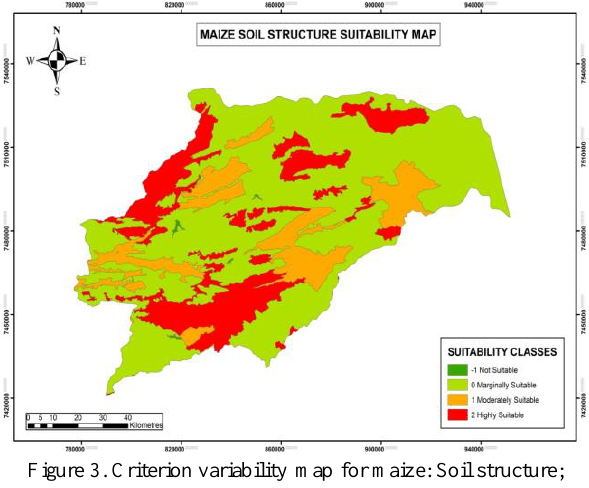
Figure 3. Criterion variability map for maize: Soil